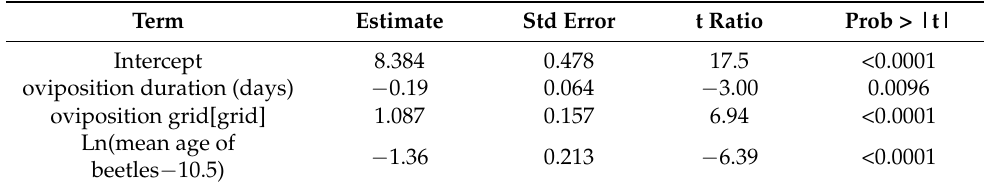
Table 2. Parameter estimates, standard error and significance level (t ratio and p -value) for multiple linear regression model of the number of eggs per beetle per day for experiment